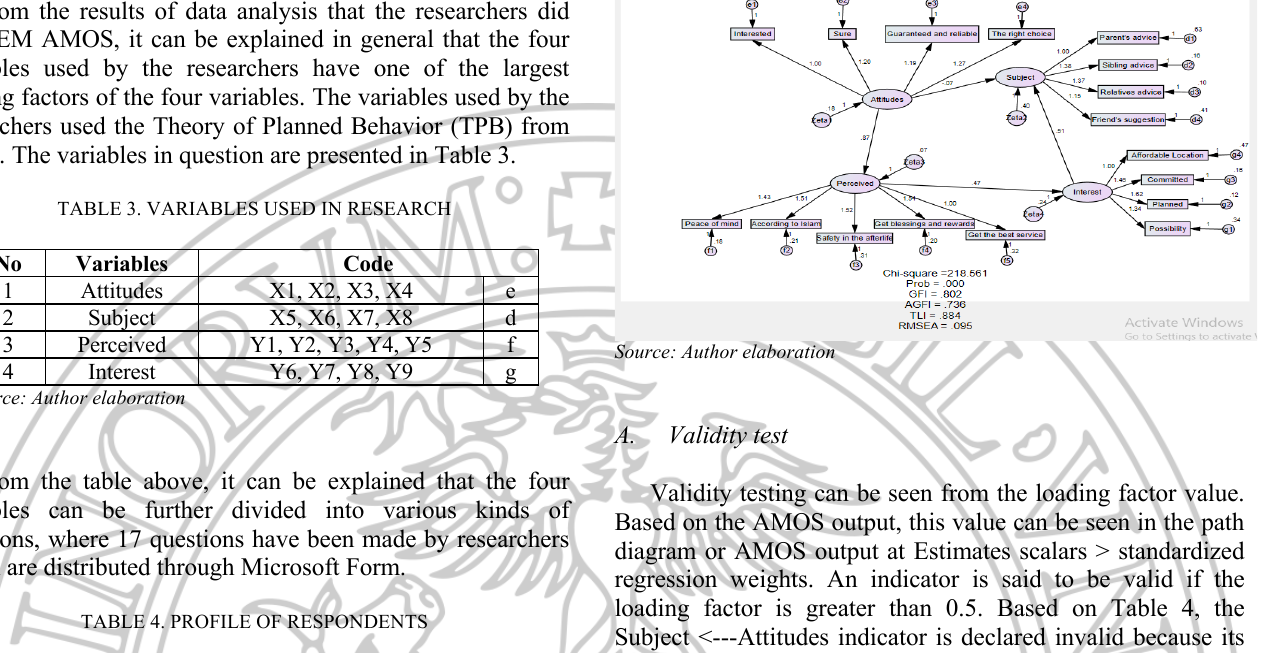
TABLE 4. PROFILE OF RESPONDENTS